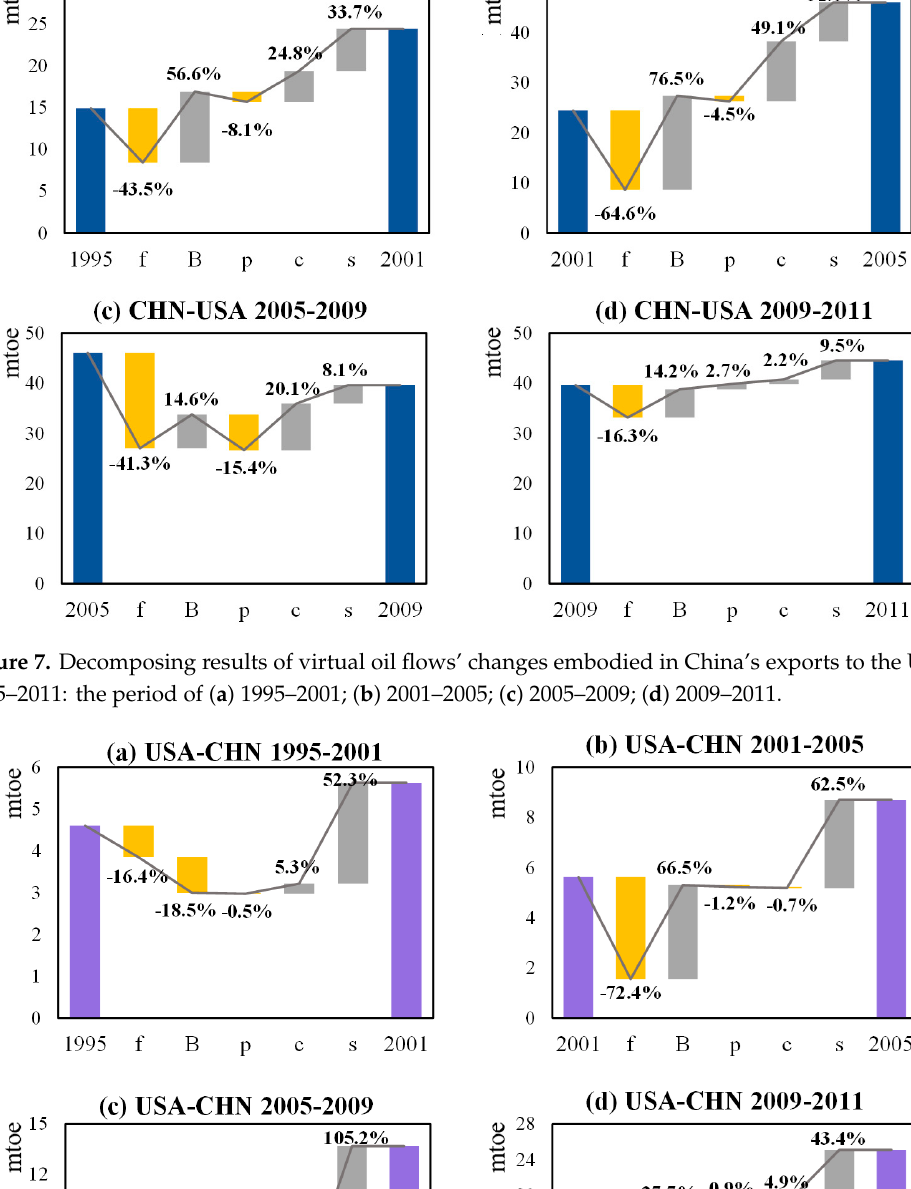
Figure 8. Decomposing results of virtual oil flows’ changes embodied in the US’s exports to China in 1995–2011: the period of ( a ) 1995-2001; ( b ) 2001-2005; ( c ) 2005-2009; ( d ) 2009-2011.